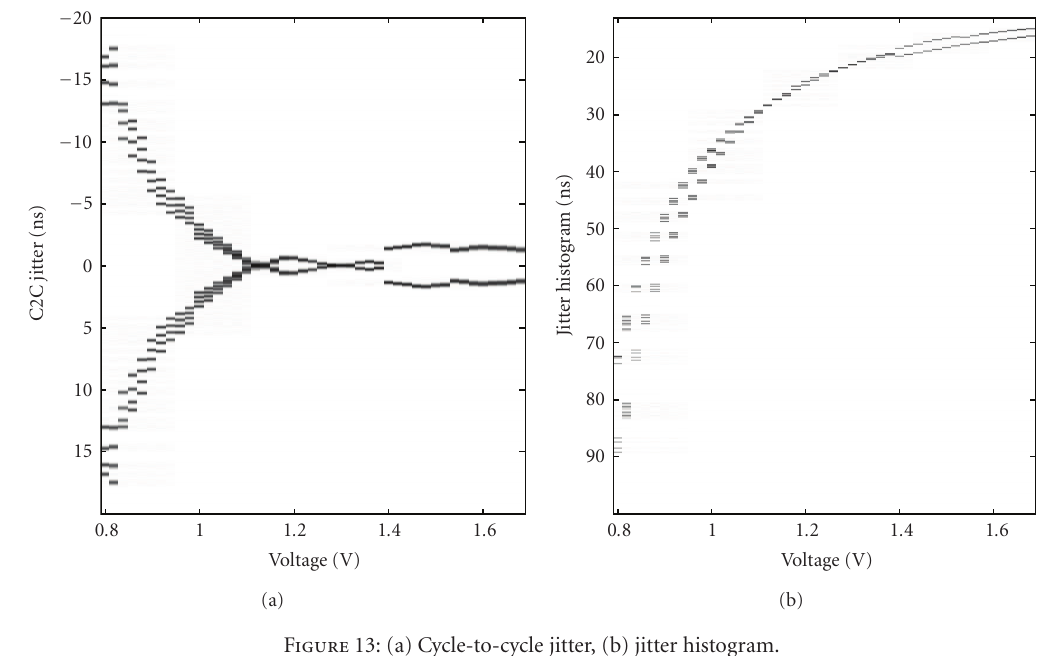
Figure 13: (a) Cycle-to-cycle jitter, (b) jitter histogram.